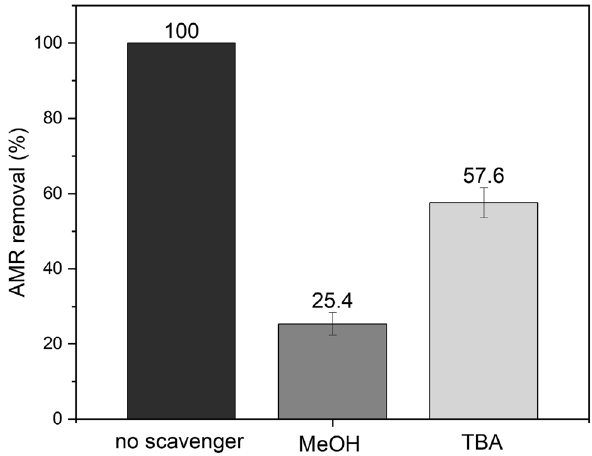
Fig. 6 Effect of quench scavenger on AMR degradation in persul- fate–ZVI system.